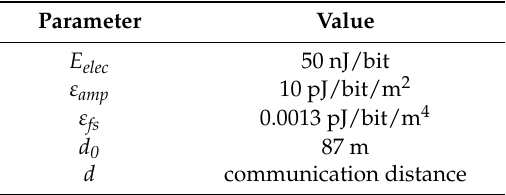
Table 3. The value of each parameter in E ( y , d